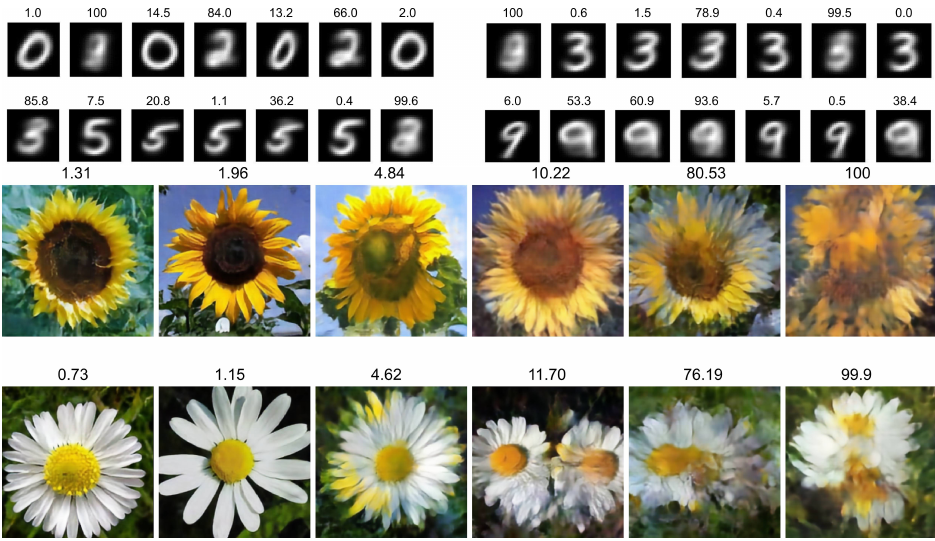
Figure 3. Generated images x ∼ p φ , t ( x | z ) with z ∼ p ( z ) and their corresponding class c obtained from the classifier p ξ , t ( y | z ) together with their open-set outlier percentage in our proposed open variational auto-encoder (OpenVAE). Image quality degradation and class ambiguity can be observed with the increasing outlier likelihood. Generated 28 × 28 MNIST images are from the 2-D latent space of Figure 2, classified as c = 0 ( top left ), c = 3 ( top right ), c = 5 ( bottom left ) and c = 9 ( bottom right ). Generated 256 × 256 resolution flower images are based on a 60-dimensional latent space of a model trained with introspection (see experiments and Appendix A.3), which are classified as “sunflower” ( top ) and “daisy” ( bottom